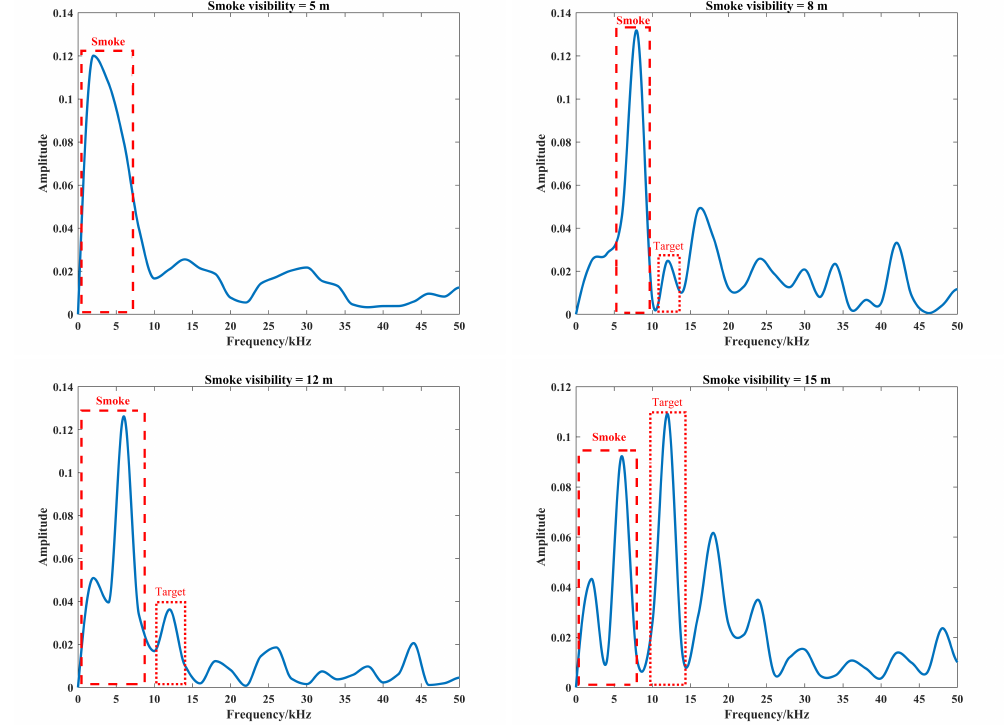
Figure 10. Spectrum of beat signal by proposed method at different smoke